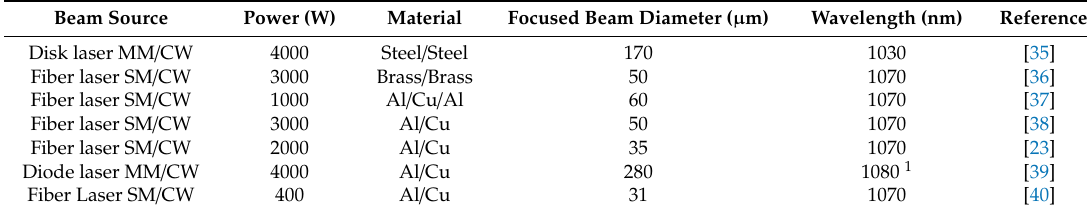
Table 2. Summary of laser types and material combinations in battery terminal welding.